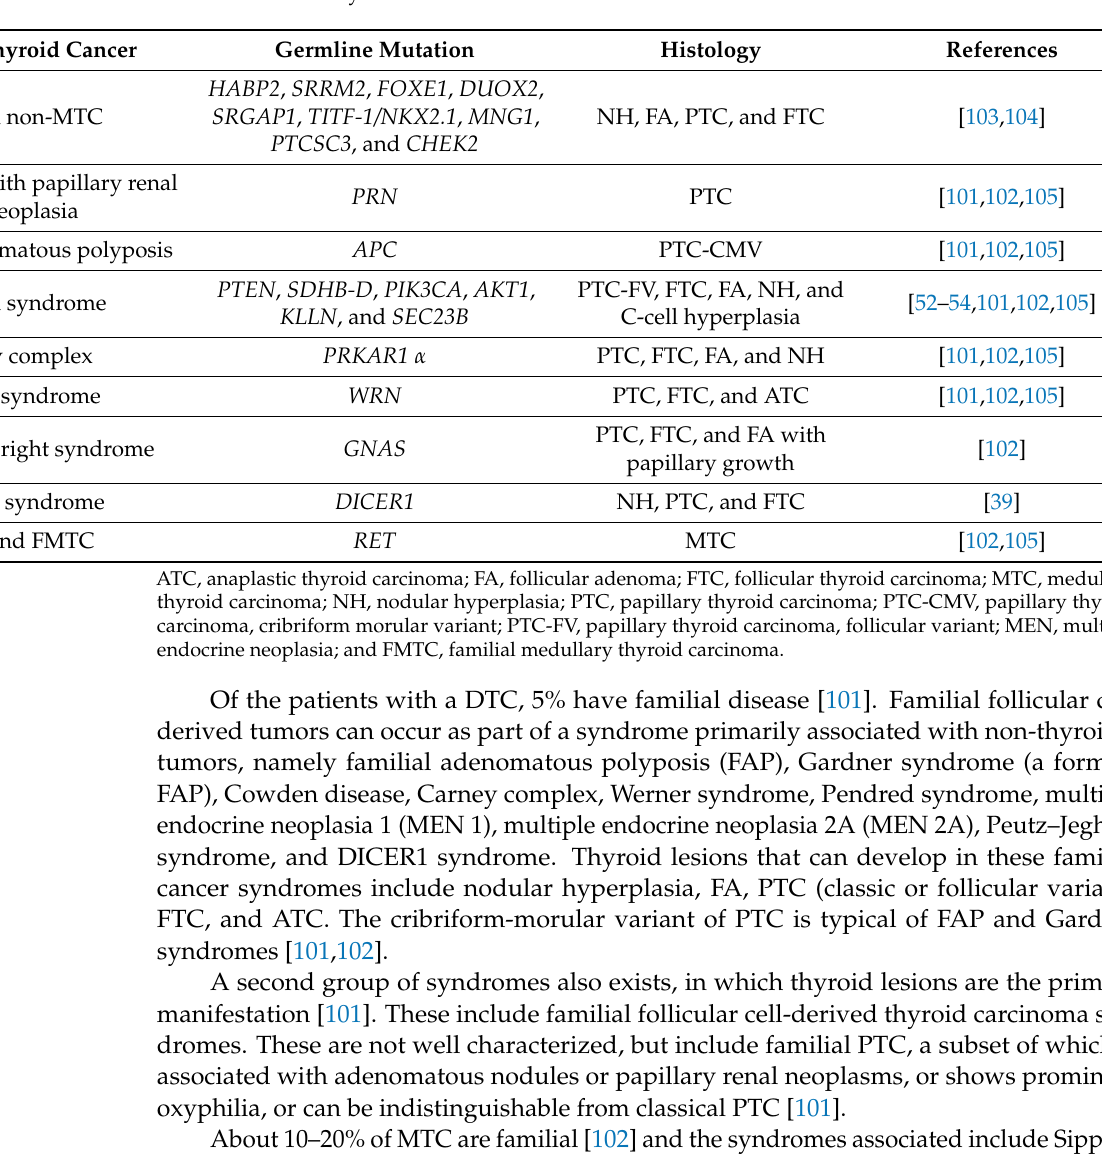
Table 1. Familial thyroid